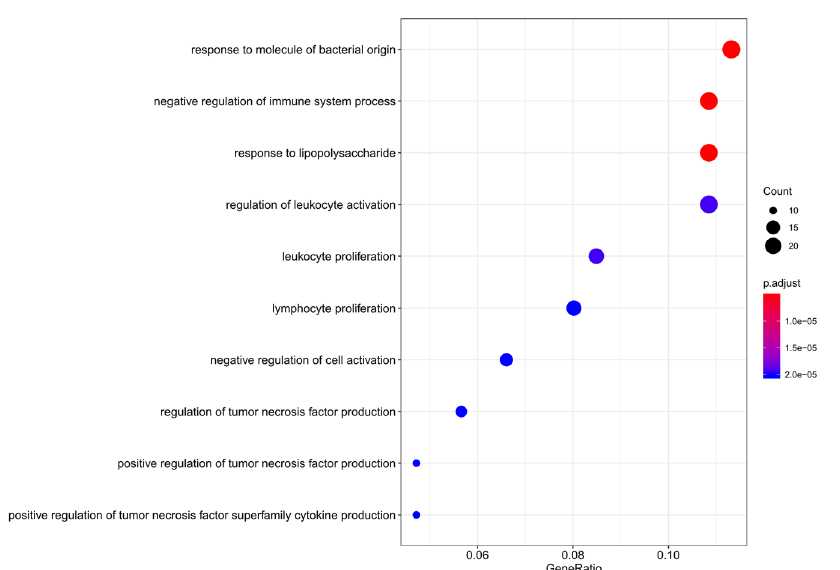
Figure 8. The first 10 Enriched GO BP terms of DEMs in Cerebral